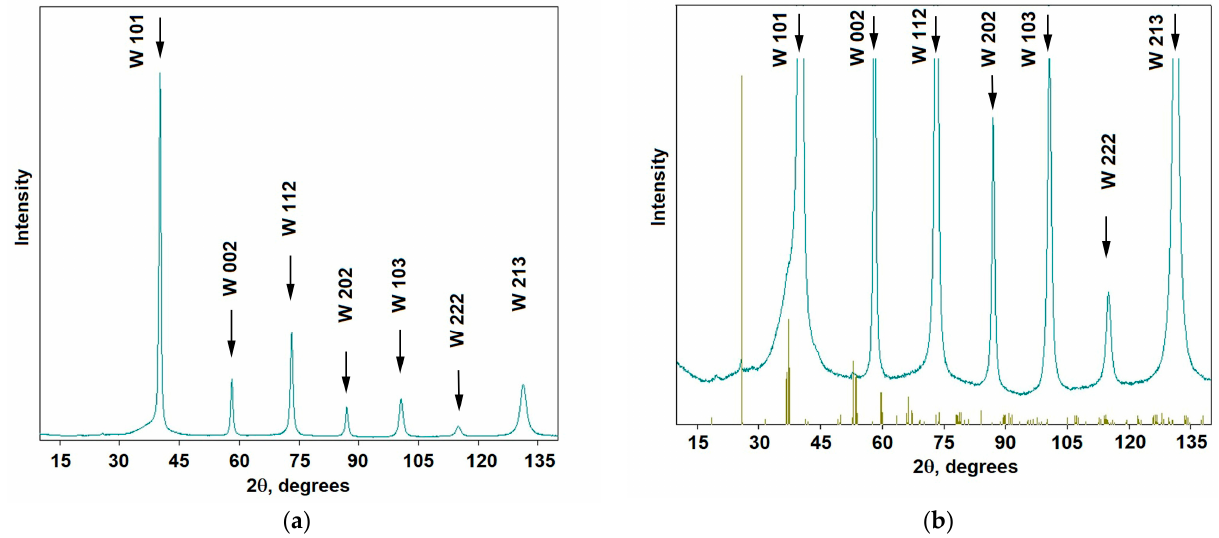
Figure 6. X-ray diffraction patterns of the composite material «tungsten + nanodiamonds»: ( a ) gen- eral view, ( b ) enlarged scale (tungsten peaks are shown with arrows, stick diagram shows tungsten oxide WO 2 ).